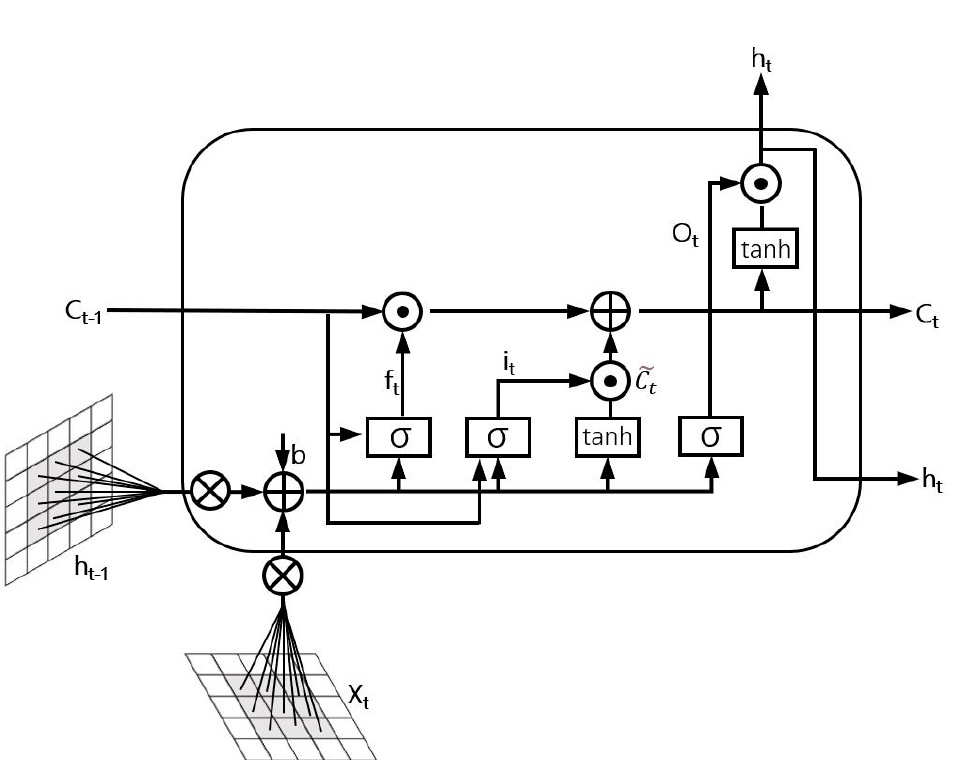
Figure 1. One cell structure of convLSTM.